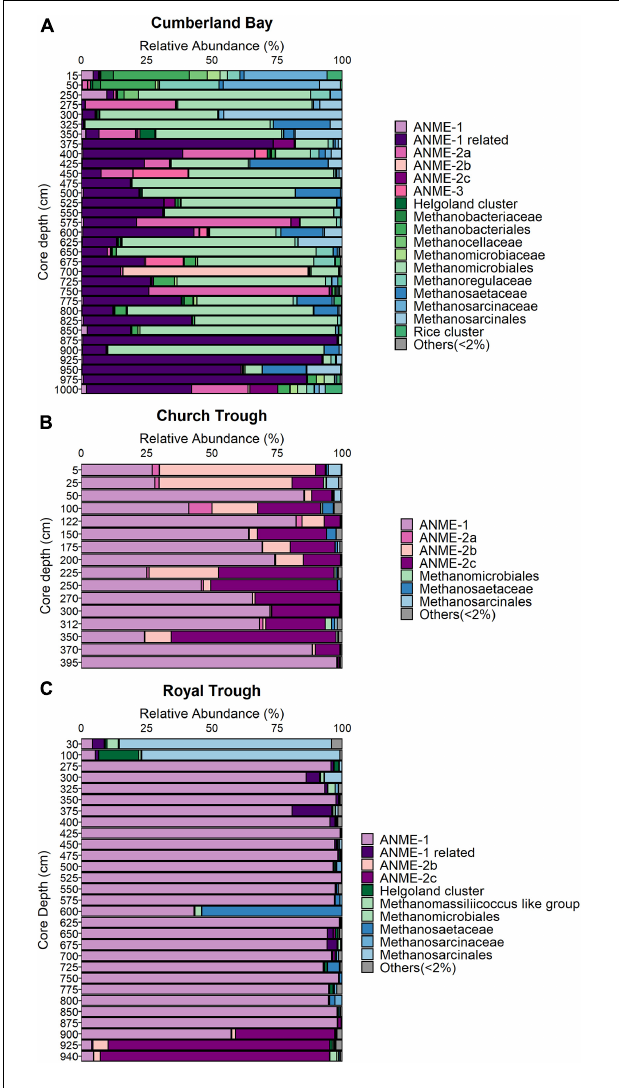
FIGURE 3 | Distribution of ANME phylotypes in South Georgia sediments. Total sum scaling of relative abundances of the mcrA gene in (A) Cumberland Bay (GeoB22043-1), (B) Church Trough (GeoB22032-1), and (C) Royal Trough